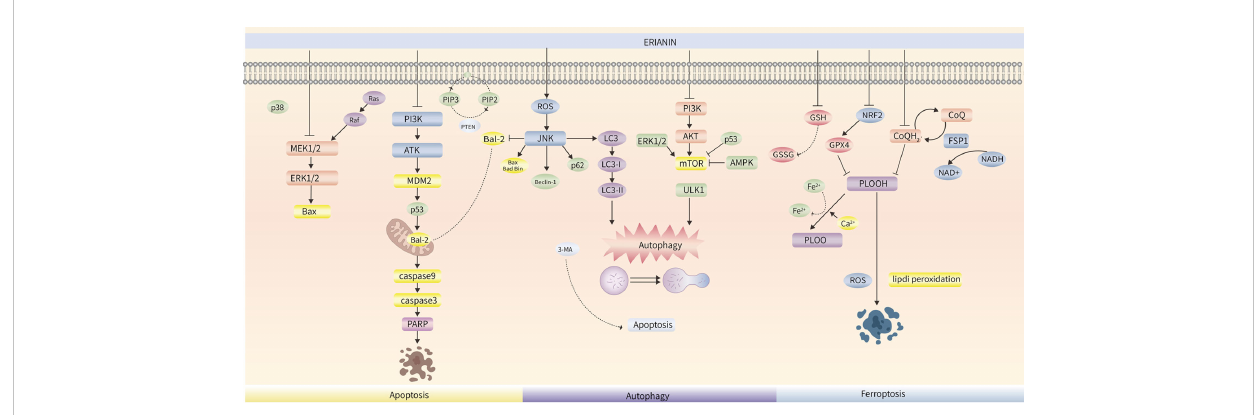
FIGURE 2 The role of ERIANIN in cell apoptosis, cell autophagy and Ferroptosis. ERIANIN regulates cell apoptosis through the MEK/ERK pathway and the PI3K/ AKT pathway. ERIANIN regulates autophagy through the classical JNK/LC3 pathway and the PI3K/AKT/mTOR pathway; In addition, ERK, p53 and AMPK pathway also play a role in the process of autophagy through the mTOR pathway; ERIANIN regulates Ferroptosis through the NRF2/GPX4/ PLOOH pathway and the CoQH2/PLOOH pathway. p38, p38 kinase; MEK1/2, serine/threonine protein kinase 1/2; ERK1/2, Extracellular signal- regulated kinase 1/2; Bax, BCL2-associated X protein; Ras, RAS oncogene homolog; Raf, Raf oncogene; PI3K, phosphatidylinositol 3-kinase; AKT, serine/threonine kinase; MDM2, MDM2 proto-oncogene; PARP, poly(ADP-ribose) polymerase; JNK, c-Jun NH2-terminal kinase; Bcl2, BCL2 apoptosis regulator; LC3, microtubule associated protein 1 light chain 3; AMPK, AMP-activated protein kinase; NRF2, NFE2 like bZIP transcription factor 2; GPX4, glutathione peroxidase 4; GSH, pyrimidodiazepine synthase; ROS, reactive oxygen species; PLOOH, phospholipid hydroperoxides; NAD+, nicotinamide adenine